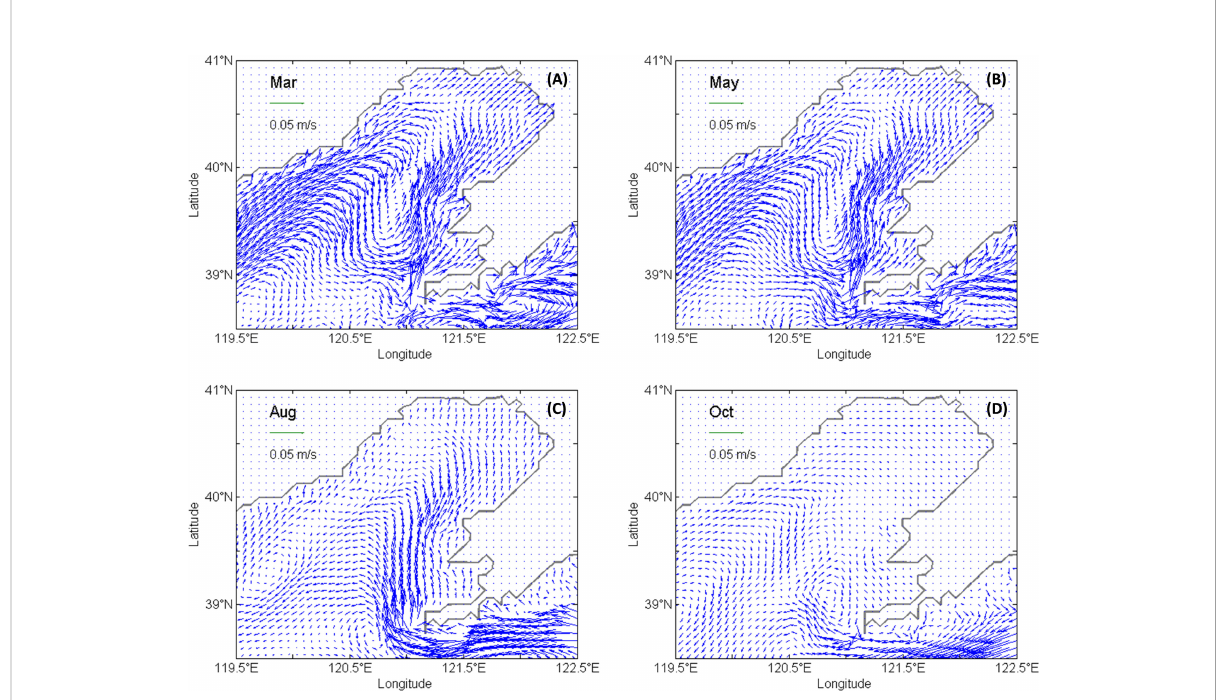
FIGURE 8 Monthly averaged currents fi eld in the Liaodong Bay. The hydrodynamic fi elds were calculated by POM and had been validated by Wang et al. (2013). The Liaodong Bay part of the hydrodynamic fi eld was interpolated to the grid of our model. (A – D) show the monthly averaged currents fi elds in March, May, August and October 2015,